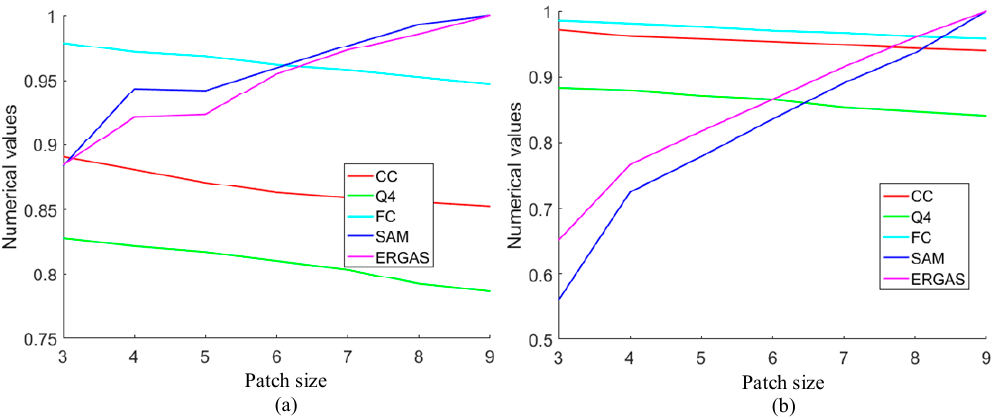
Figure 7. The variations of metrics with different patch size. ( a ) Performance influence of patch size on QuickBird image datasets, ( b ) Performance influence of patch size on Geoeye-1 image datasets.